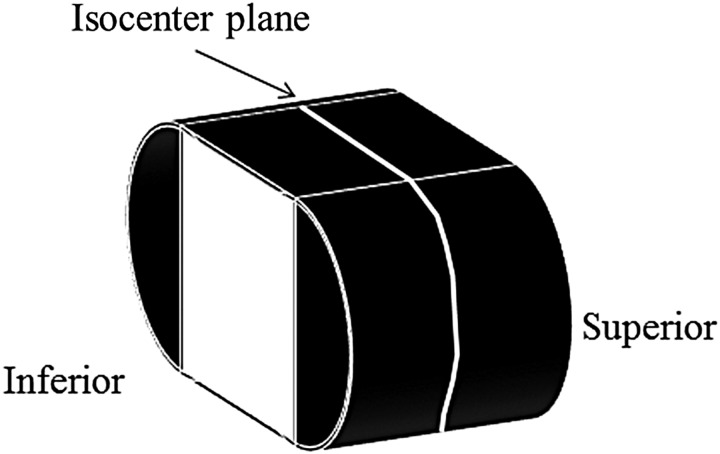
Measurement locations for a dose distribution. One sheet of film was inserted into the phantom's isocenter plane in the cranio–caudal direction.